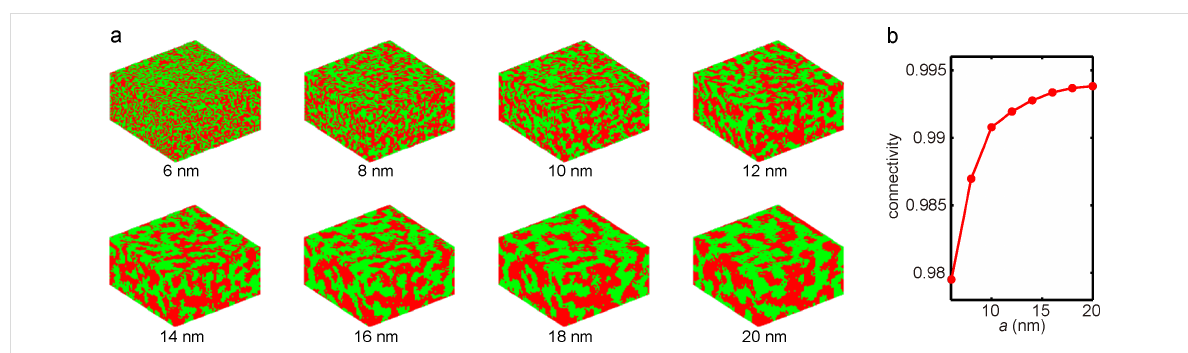
Figure 4: (a) Morphologies generated for 1:1 P3HT (green)/PCBM (red) and (b) the dependence of the connectivity ratio on the domain size for the morphologies in